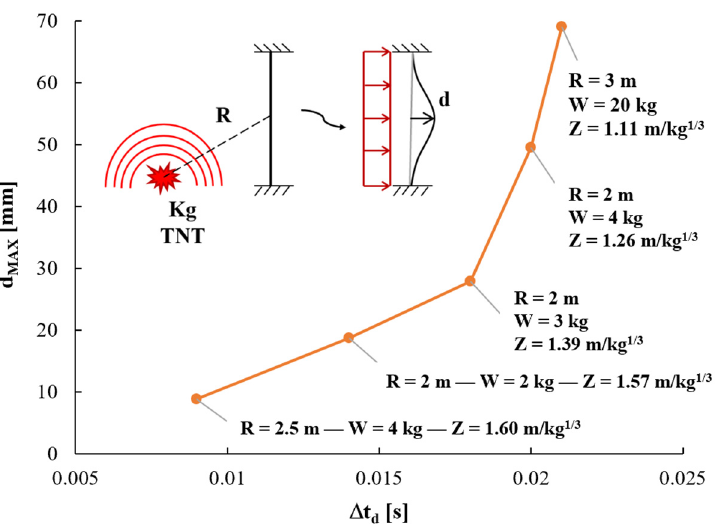
Figure 8. Blast local demand curve midspan maximum displacement vs. peak response